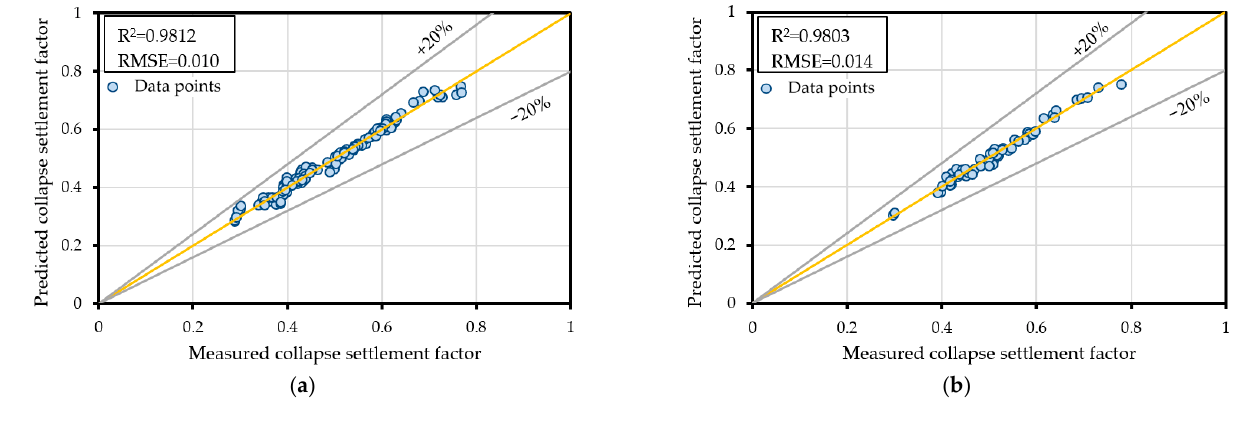
Figure 9. Comparing the results of the predicted and measured coefficient of stress release based on the secant hyperbolic function. ( a ) Training data, ( b ) Testing data.